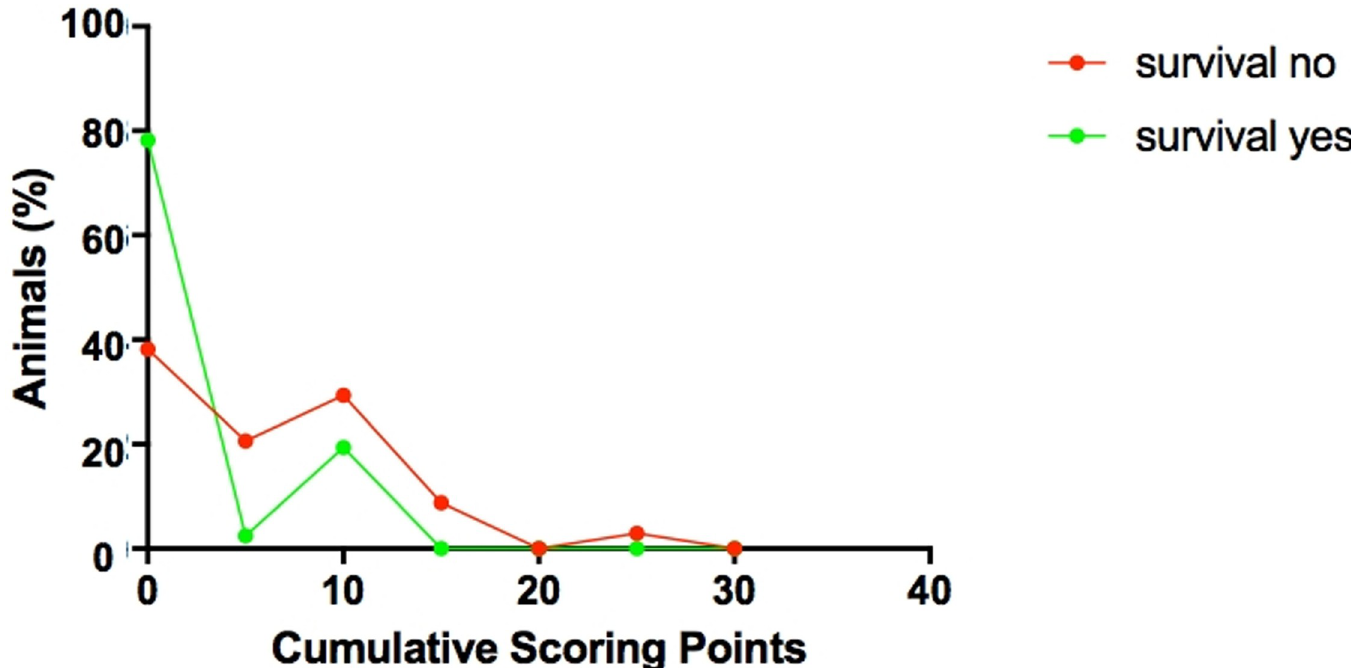
Fig 11. Graphical illustration showing the correlation between postoperative total scoring points and survival. A comparison of the green curve (survival yes) and the red curve (survival no) shows that more animals (y-axis) with a lower score (x-axis) survived.